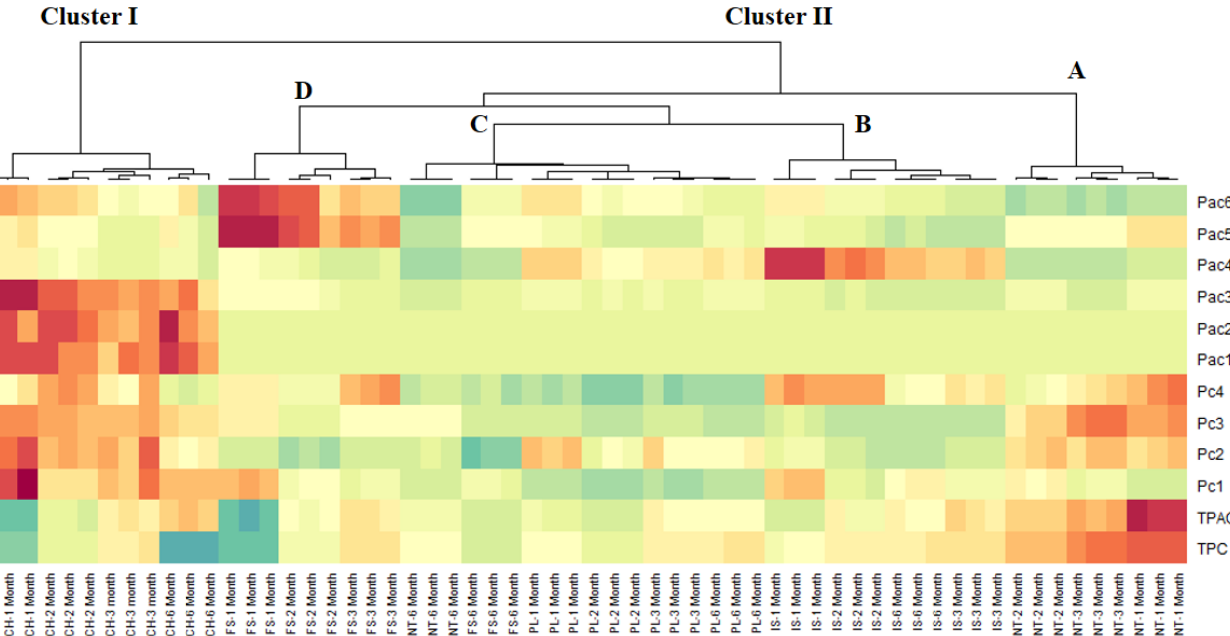
Figure 3. Principal component analysis (PCA) showing the variability of the antioxidant and anti-enzymatic activity of comfrey roots depending on the storage period and geographical region. ( A ). Eigenvalues and percentage of explained variance of each principal component (PC). ( B ). Loading plots displaying the relationship between the biological activities and the three significant PCs. ( C ). Score plots showing the distribution of the samples in the three two-dimensional plans obtained from the three significant PCs. ABTS, 2,2′ -azino-bis(3-ethylbenzothiazoline) 6-sulfonic acid; AChE, acetylcholin- esterase; BChE, butyrylcholinesterase; CUPRAC, cupric ion reducing antioxidant capacity; DPPH, 1,1-diphenyl-2-pic- rylhydrazyl; FRAP, ferric ion reducing antioxidant power; MCA, metal chelating activity; PDA, phosphomolybdenum activity.